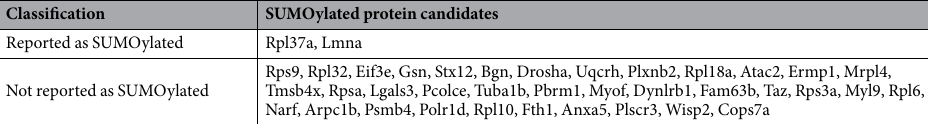
Type of the included sequences